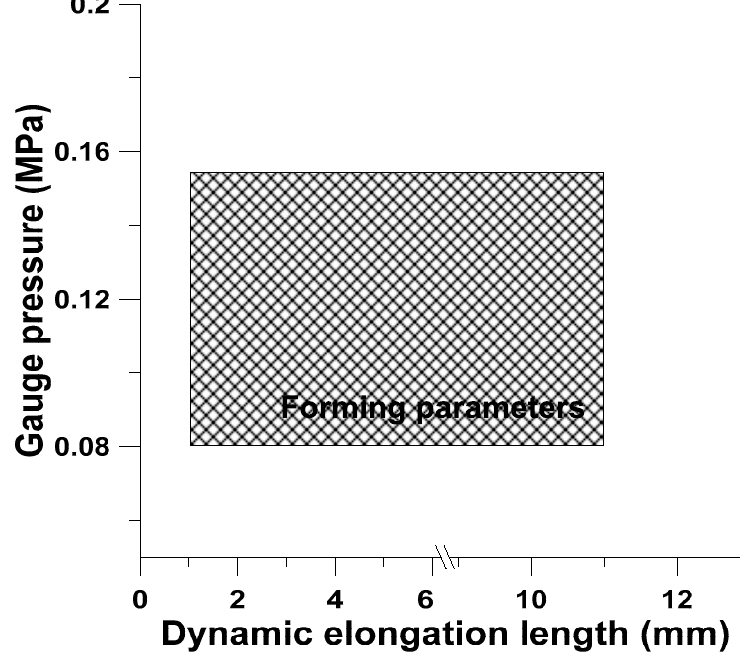
Figure23. Figure 23. Dynamic tensile gasbag-assisted imprinting process reproduction forming operation window.